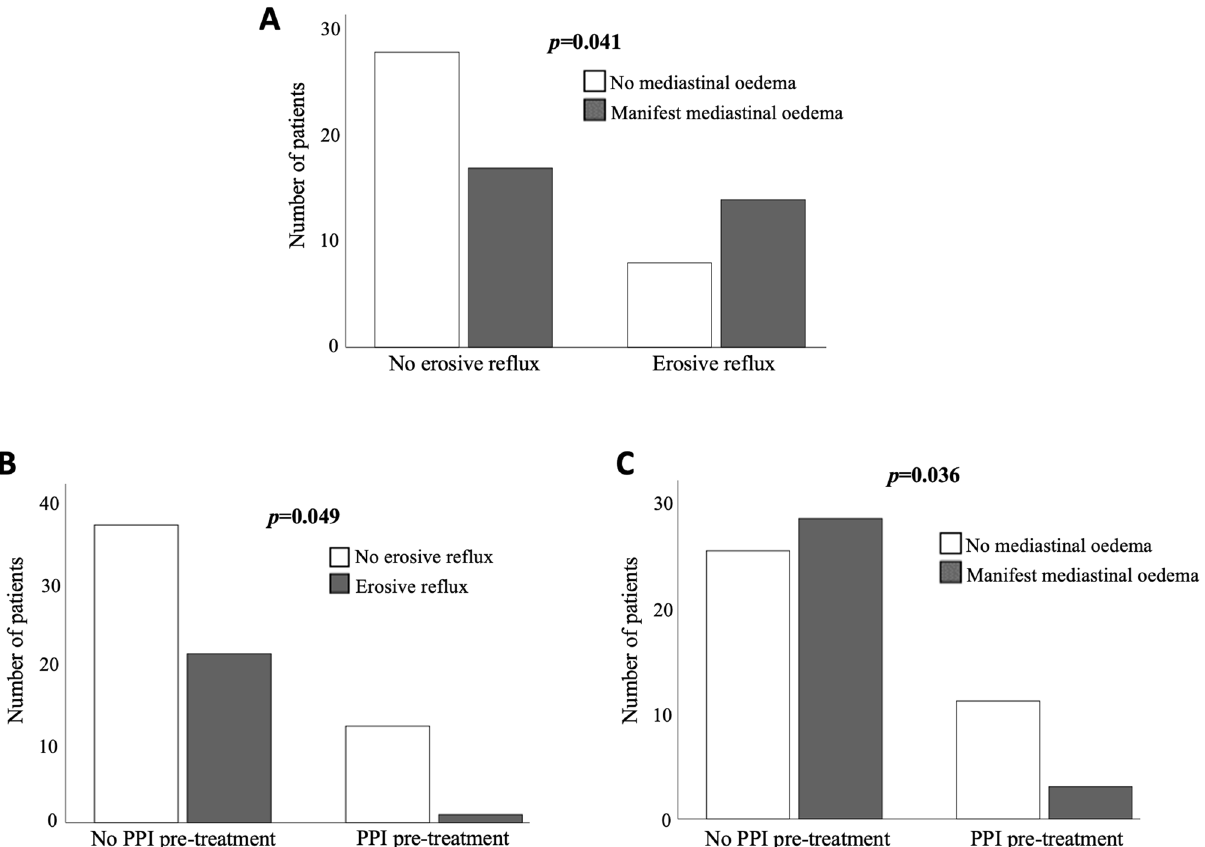
Figure 3. Impact of oesophageal reflux disease and prior PPI-treatment on PVI safety outcome. ( A ) PVI- associated mediastinal oedema were significantly more frequently detected in patients with pre-existing erosive oesophageal reflux disease compared to non-reflux patients ( p = 0.041). Shown is the number of patients with or without mediastinal oedema after PVI. ( B ) Patients with constant PPI medication prior to PVI significantly suffered less frequently from erosive oesophageal reflux disease, assessed directly prior to PVI by EDG, compared to patients without prior constant PPI intake ( p = 0.049). Shown is the number of patients with or without erosive oesophageal reflux prior to PVI. ( C ) In patients with constant PPI-treatment prior to PVI, PVI-associated mediastinal oedema were significantly less frequently observed by post-interventional endosonography ( p = 0.036). Shown is the number of patients with or without mediastinal oedema after PVI. EGD, oesophagogastroduodenoscopy; PPI, proton pump inhibitor; PVI, pulmonary vein